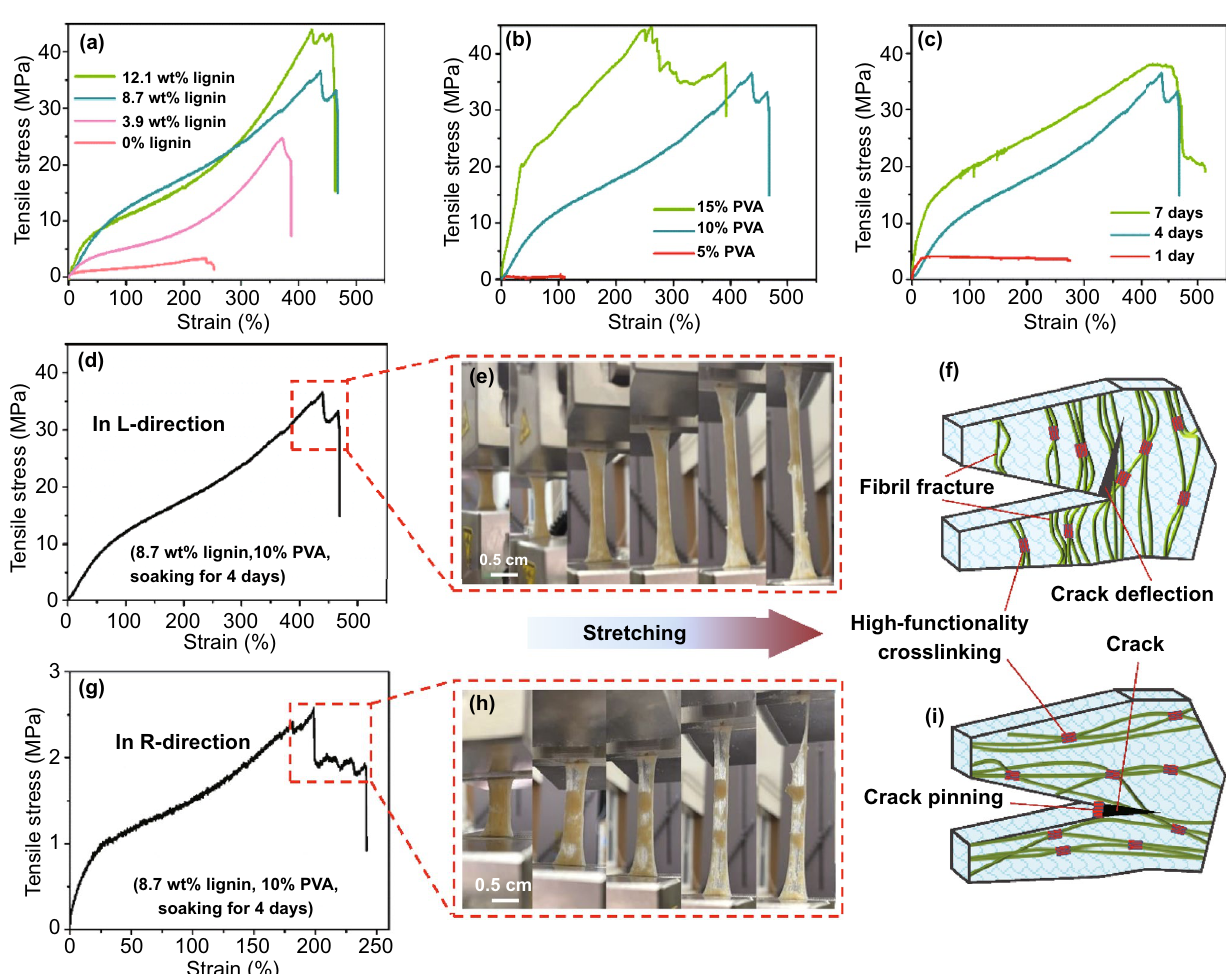
Fig. 5 The mechanical strength and cross-linking mechanism of the all-wood hydrogel. The effect of a lignin content, b PVA content, and c salting time in the 1.5 M sodium sulfate solution on the tensile strength of the all-wood hydrogel in the L-direction, respectively. d The tensile stress–strain curves for all-wood hydrogel in the L-direction and e its fibrotic fracture during tension, and f the tensile mechanism at this state. g The tensile stress–strain curves for all-wood hydrogel in the R-direction and h its fibrotic fracture during tension, and i the tensile mechanism at this state. Here, the samples contain 10% PVA, soaking for 4 days, and different content of lignin in (a); the samples contain 8.7 wt% lignin, soaking for 4 days, and different content of PVA in (b); and the samples contain 8.7 wt% lignin, 10% PVA, and different salting time in (c). Besides, the samples are composed of 10 wt% PVA, 8.7 wt% lignin, and soaking for 4 days in (d,